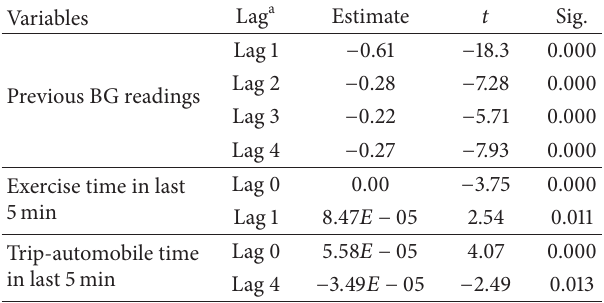
Table 2: Correlation with mean blood glucose calculated over 12- hour periods ( 𝑛 = 170 , 34 participants × 5 twelve hour periods).